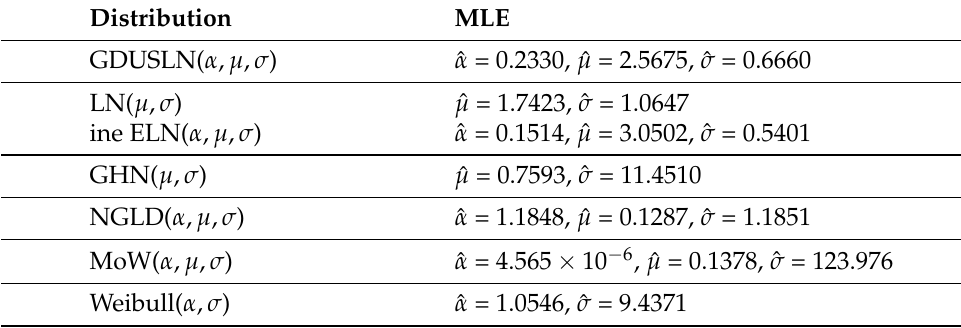
Figure 4. The TTT plot of bladder cancer dataset. Table 10. Bladder cancer dataset: MLEs of the